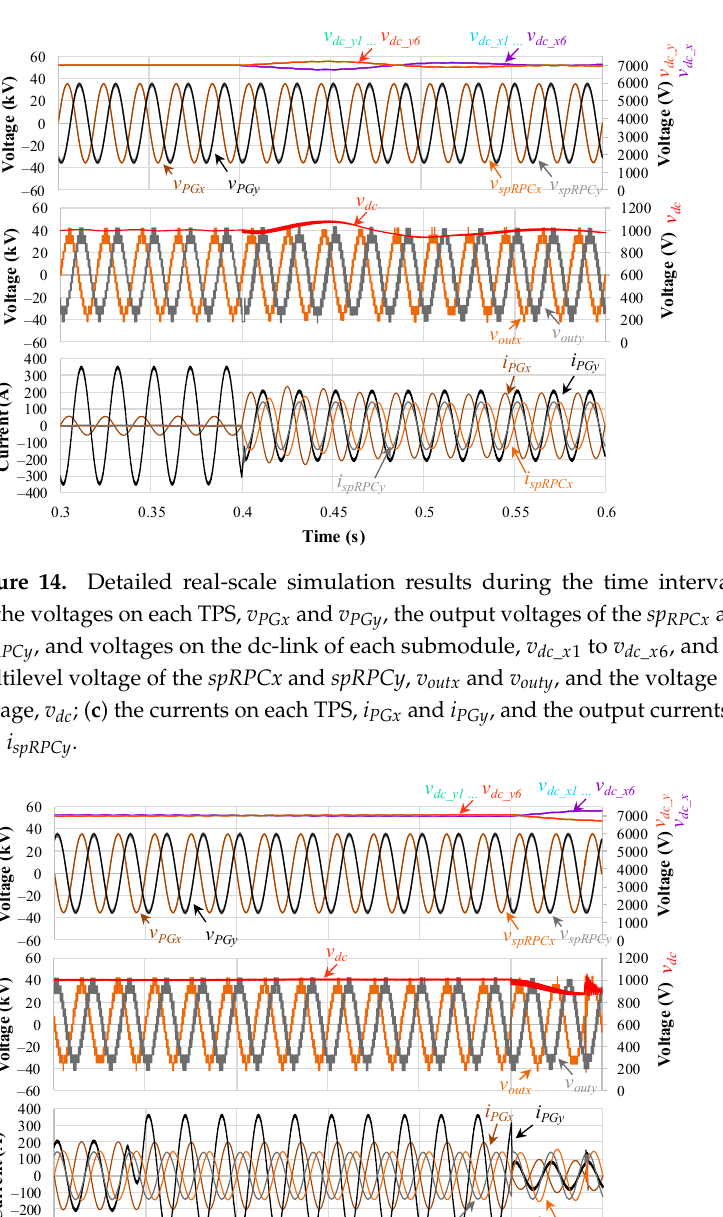
maximum value of 364.8 A, and a new unbalance appears. At instant 1.2 s, the proposed control algorithm updates the operation reference values, as can be seen with the amplitude change of the i spRPCx and i spRPCy , being able to verify that i PGx and i PGy converge again to similar amplitude values.